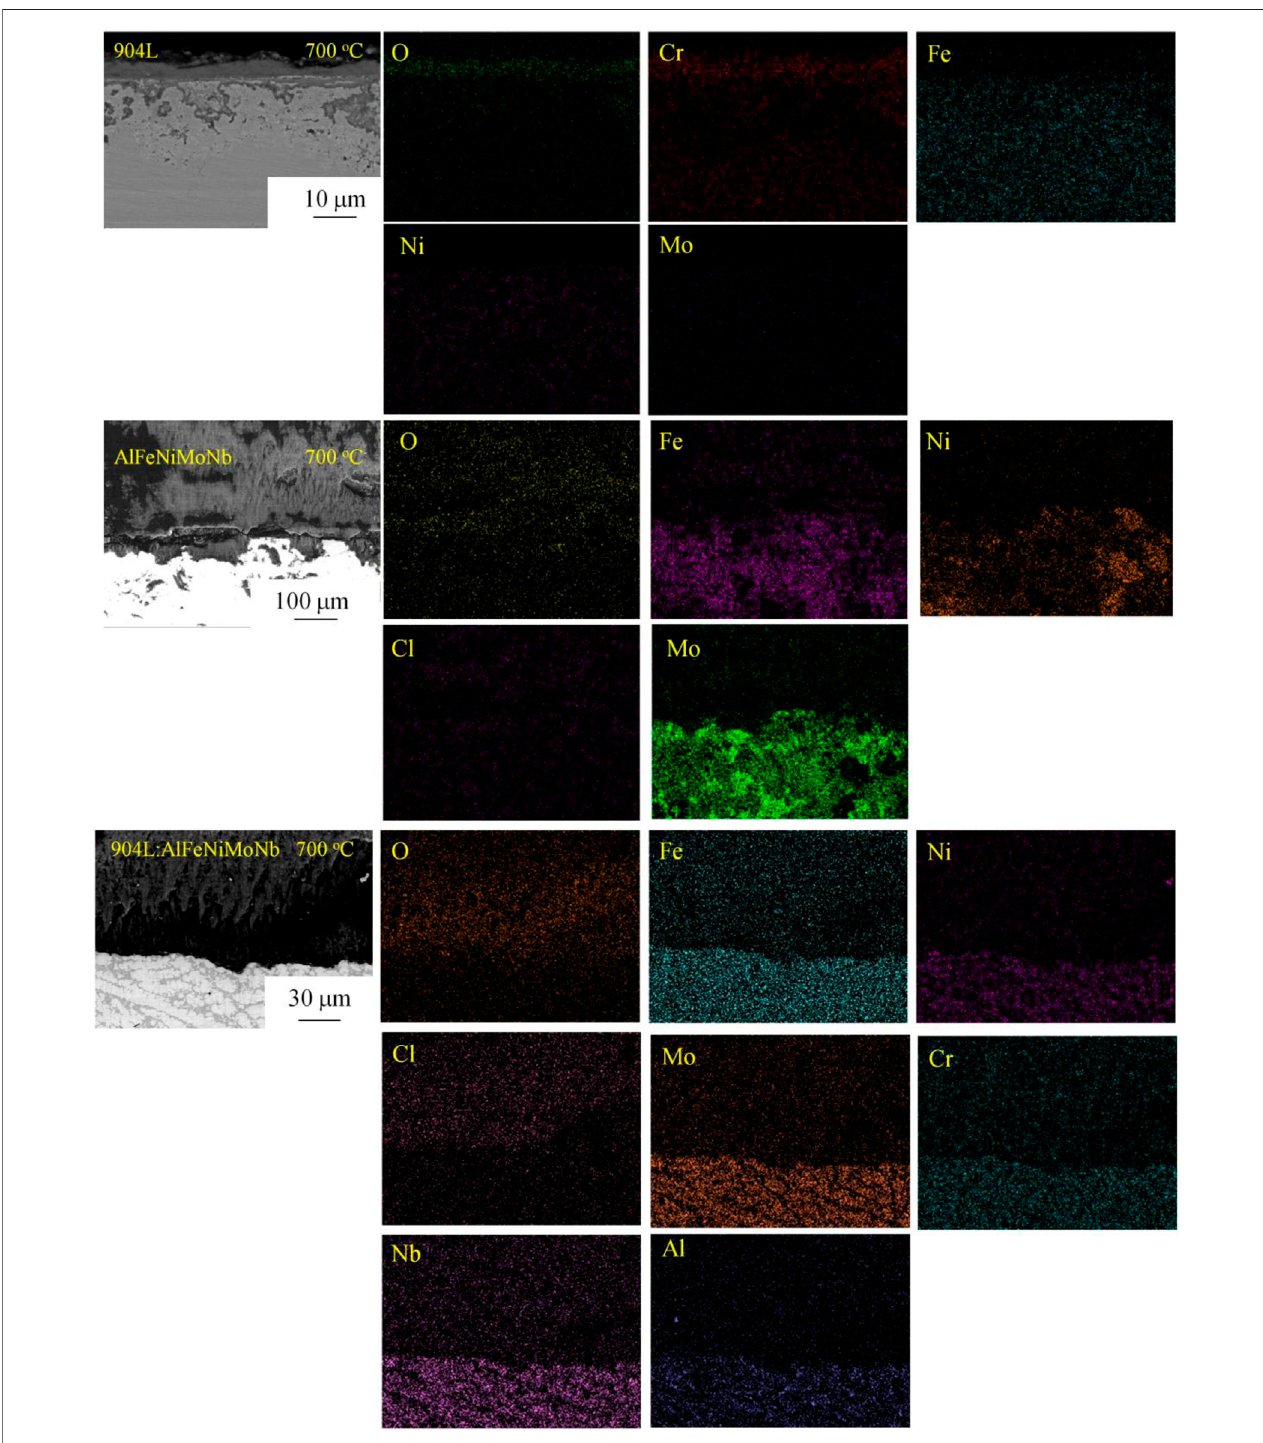
FIGURE 15 | Element mapping of the cross-section of the corroded samples corroded under N 2 – 2.6 vol.% CO 2 – 1.3 vol.% O 2 – 2,700 vppm HCl gaseous environment at 700 ° C for 55 h.